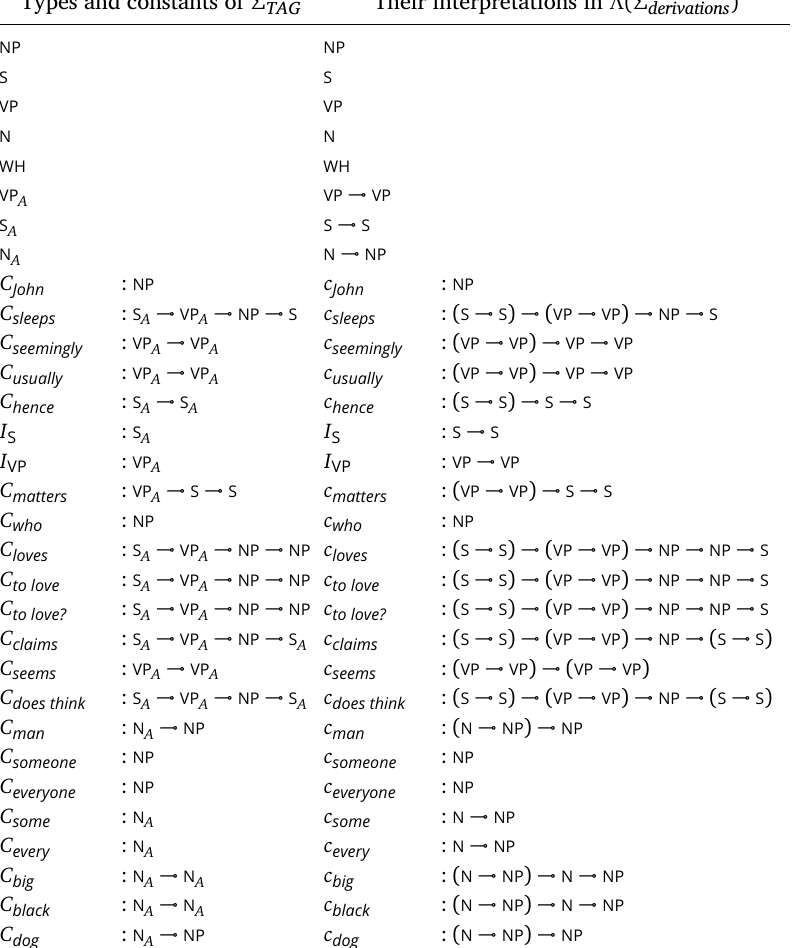
Table 13: (cid:6) TAG constants and